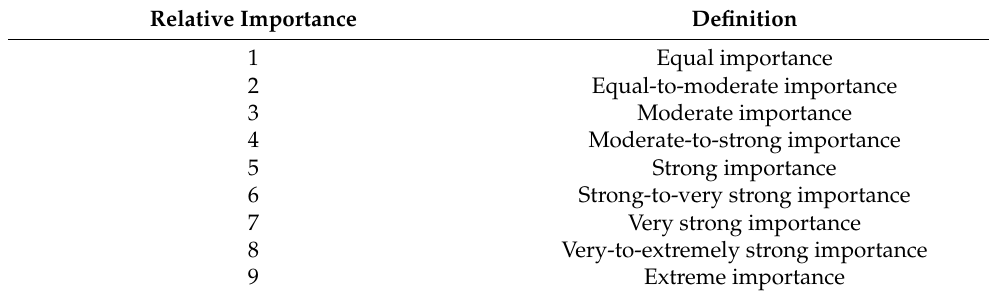
Table 1. Saaty’s criterion weight scale.